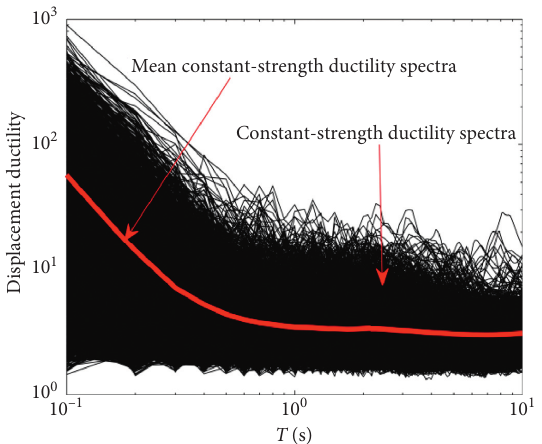
Figure 4: Constant-strength ductility spectra of selected ground motion records.